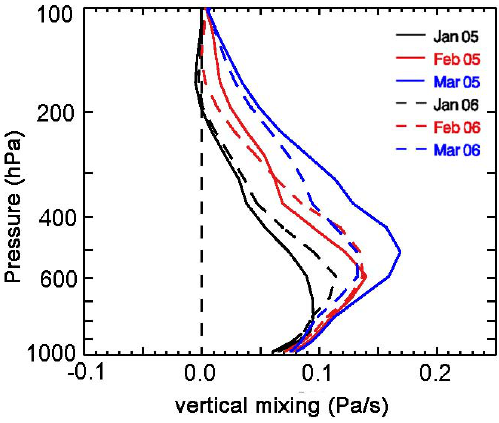
Fig. 24. Vertical profiles of total air mass flux (convection and ad- vection) in GEOS-4 in the Gulf of Guinea from January to March in 2005 and 2006. Solid lines represent 2005 and dashed lines rep- resent 2006.